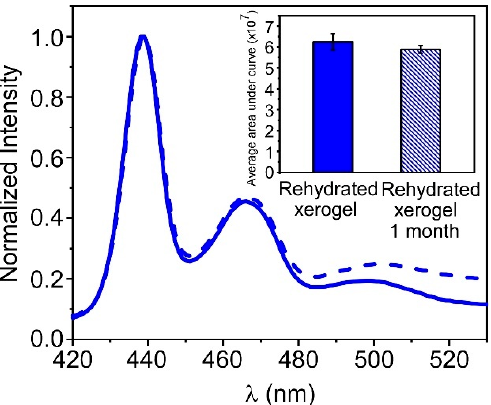
Figure 7. Normalized fluorescence emission spectra of rehydrated PFO@AETA xerogels stored at room temperature for one day (solid line) and one month (dashed line). Inset: average area under the (non-normalized) emission spectra of different portions (n = 3) of rehydrated xerogels stored for one day and one month ( 𝜆 x = 396 nm). Error bars represent the standard deviation of the three rep- licates.